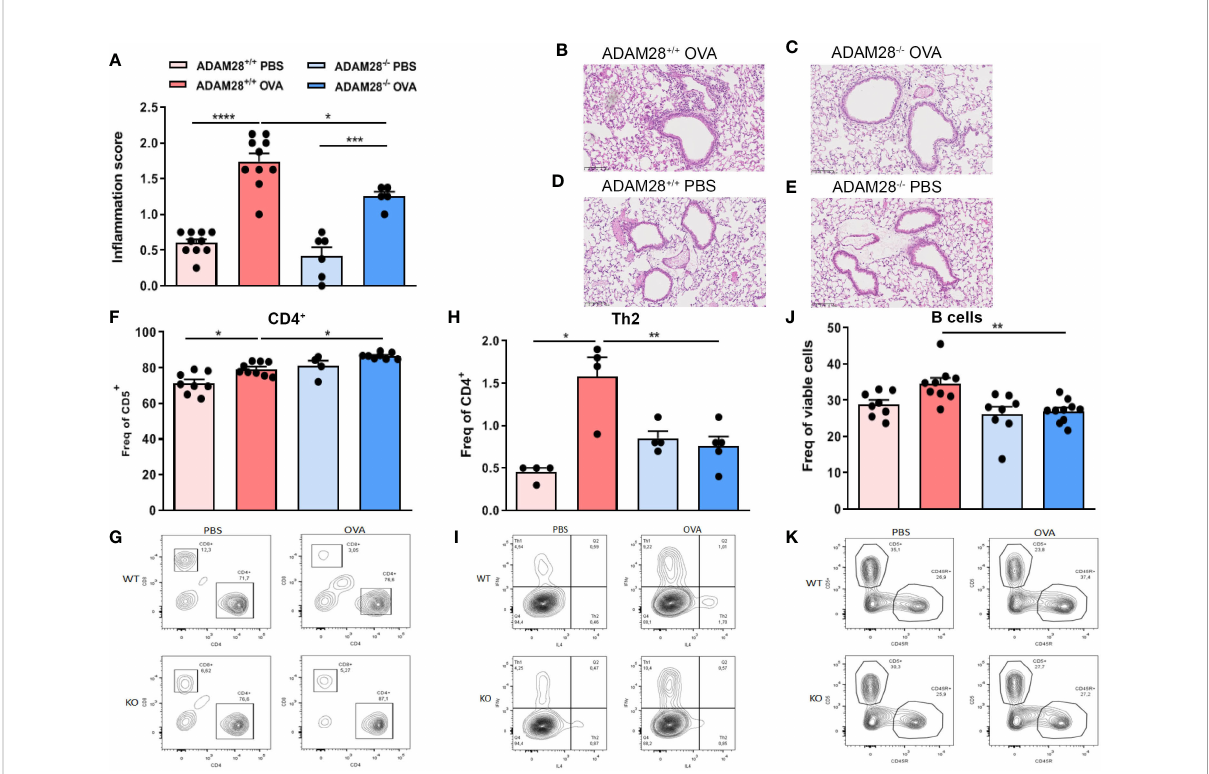
FIGURE 3 Effects of ADAM28 depletion on allergen-induced in fl ammation in lung tissue . Histological score estimating the peribronchial in fl ammation quanti fi ed from haematoxylin-eosin (H&E) stained lung section of mice lungs (N=3; ADAM28 +/+ - PBS n=10, ADAM28 +/+ -OVA n=10, ADAM28 -/ – PBS n=6, ADAM28 -/ – OVA n=5) (A) . Representative H&E staining of lung sections. Scale bar: 100 m m. (B-E) . Measurement of cell numbers in digested lung: CD4 + /CD5 + ratio (N=2; ADAM28 +/+ - PBS n=8, ADAM28 +/+ -OVA n=9, ADAM28 -/ – PBS n=4, ADAM28 -/ – OVA n=8) (F) and corresponding contour plot of one representative animal for each condition (G) ; IL4 + and CD4 + cells that corresponds to the proportion of Th 2 among Th cells (N=1; ADAM28 +/+ - PBS n=4, ADAM28 +/+ - OVA n=4, ADAM28 -/ – PBS n=4, ADAM28 -/ – OVA n=5) (H) and corresponding